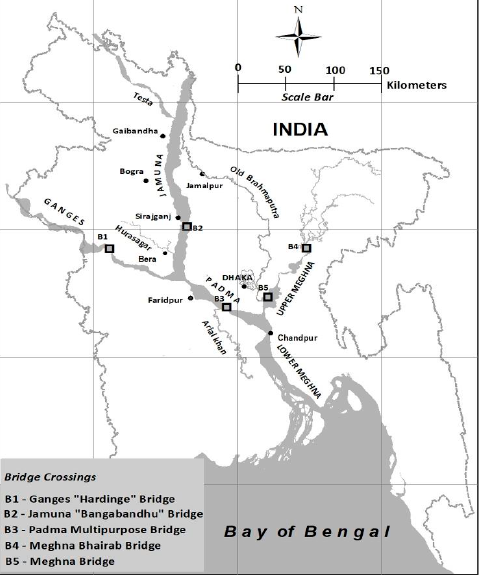
Figure 1. Bangladesh with main rivers and locations relevant to this article.